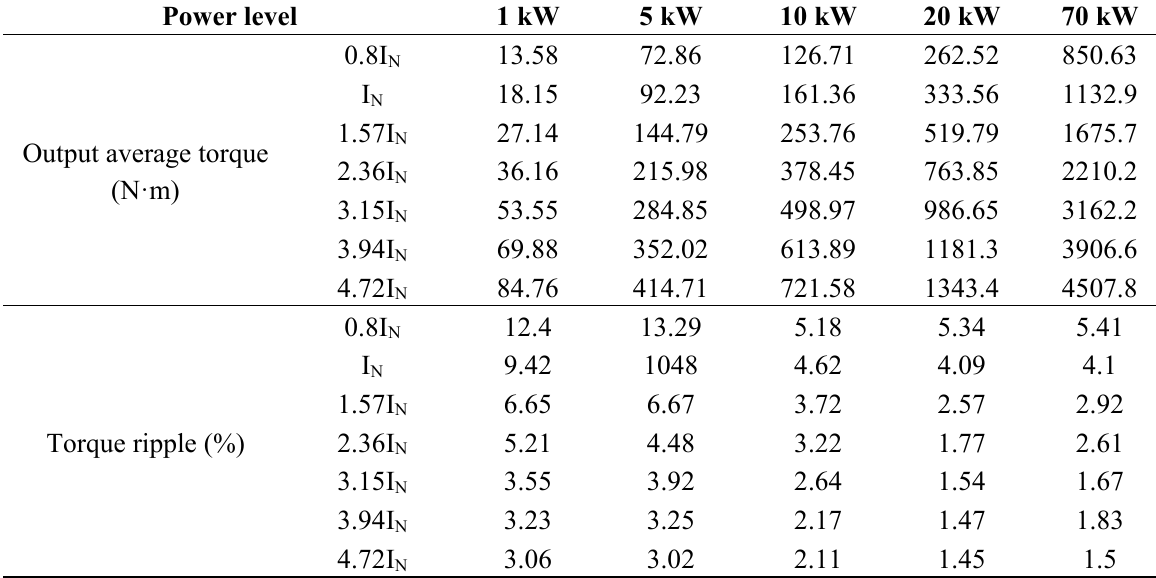
Figure 8. The torque performances of ( a ) 1 kW; ( b ) 5 kW; ( c ) 10 kW; ( d ) 20 kW; ( e ) 70 kW. Table 3. The torque performances of DRPMSM in different load